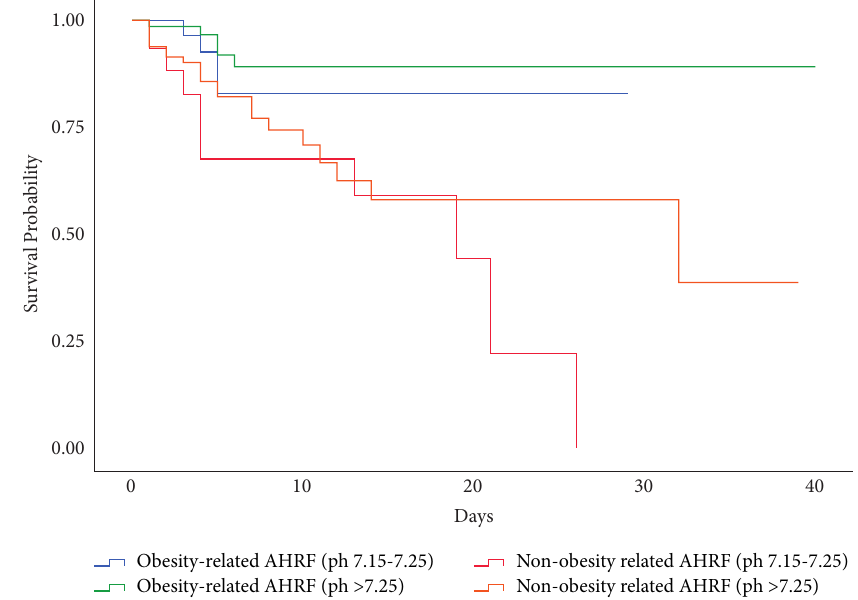
Figure 1: Kaplan–Meier curves illustrating in-hospital mortality in patients stratified by diagnostic condition (obesity-related AHRF vs. non-obesity-related AHRF) (log-rank: p � 0 .